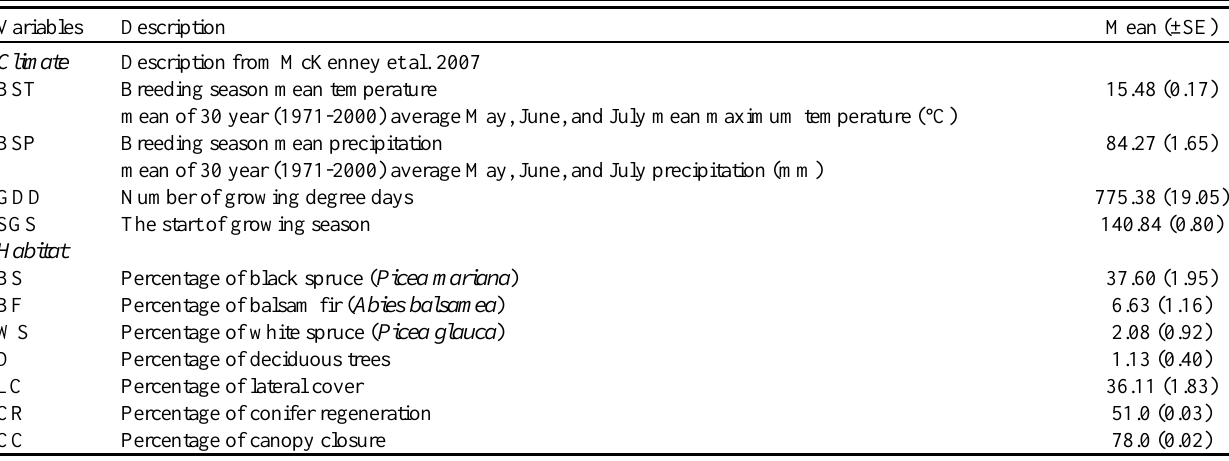
Table 1 . Definition and mean (SE) of environmental variables included in the analysis from stands sampled within the boreal forest of Québec,